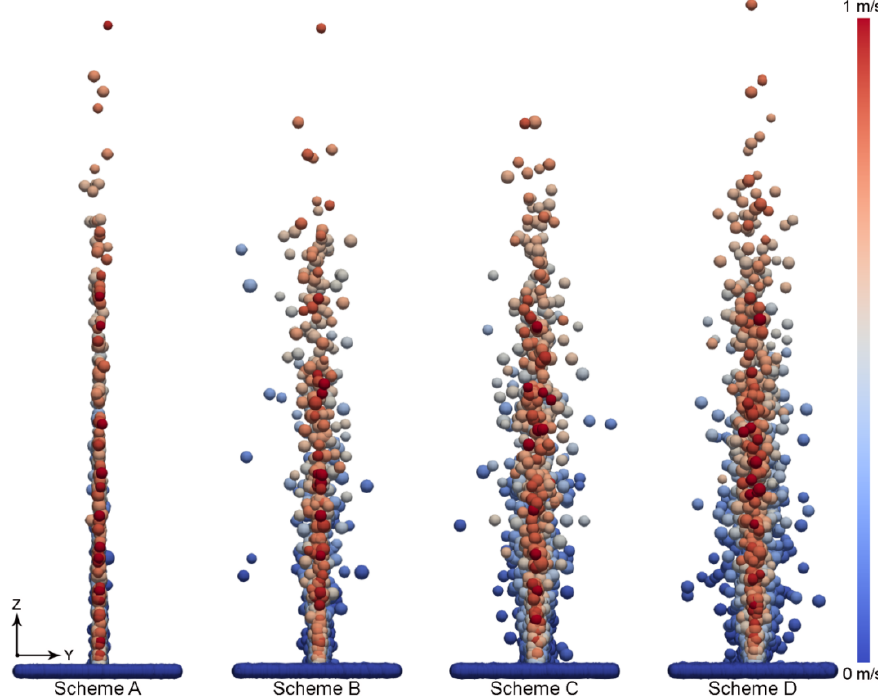
Figure 8. Side view of particle distribution at t = 0.22 s for different simulation schemes (the particles are enlarged 10 times to visualize the particle positions; particle colors represent particle speeds).